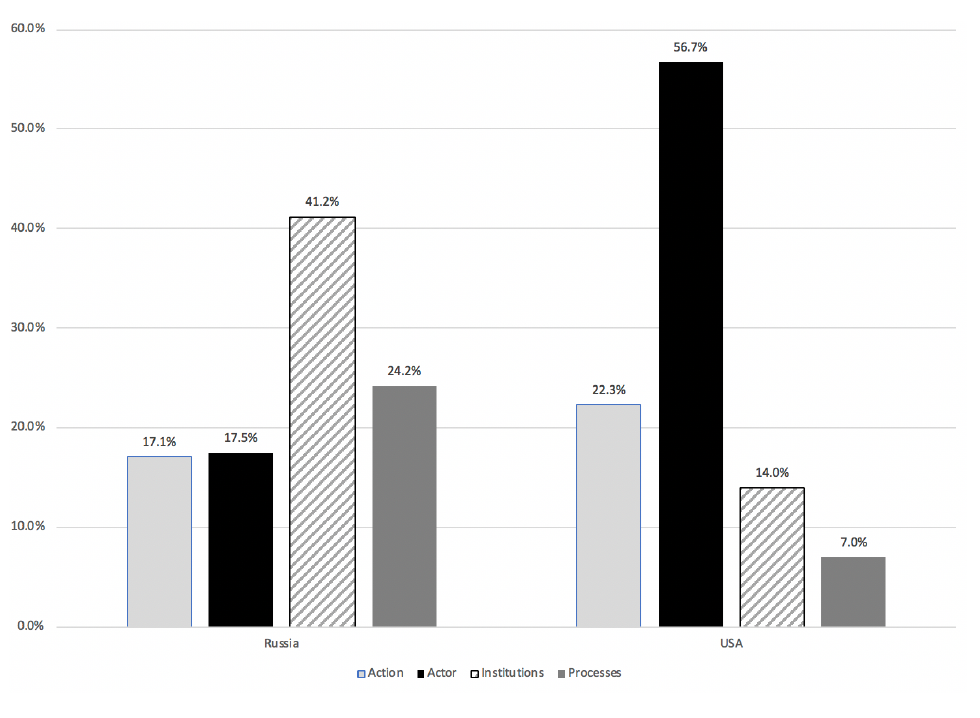
Figure 2: Proportion of references to objects framed, by